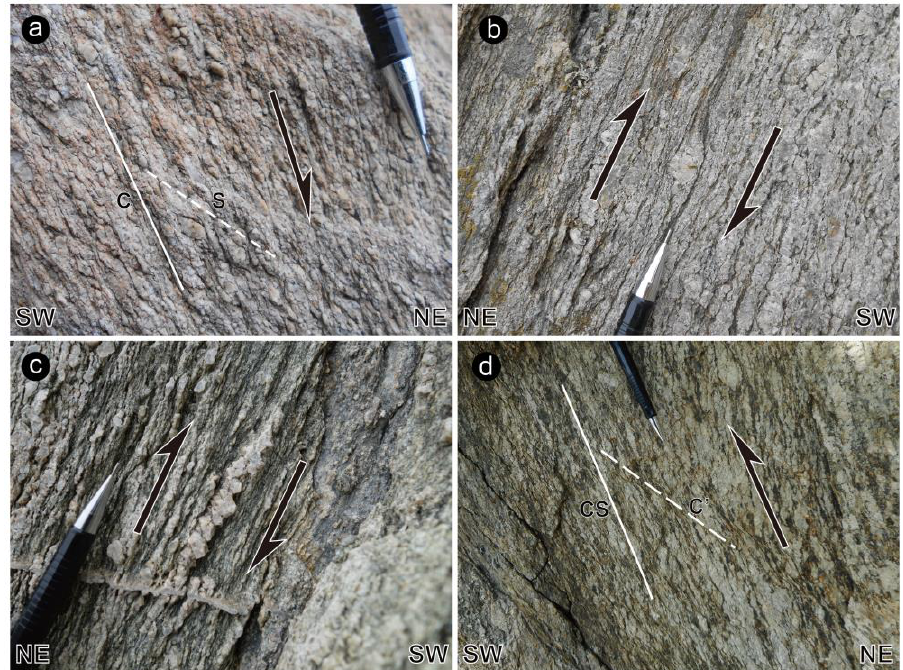
Figure 6. Outcrop-scale shear sense indicators in the Deokjeok Shear Zone (DSZ) ( a ), and the Soya Shear Zone (SSZ) ( b – d ). ( a ) S–C structure. ( b ) σ-type strain shadow. ( c ) Antithetic shear fracture (bookshelf structure). ( d ) Extensional crenulation cleavage (C’ shear band) inclined at 30°–40° to the earlier CS-foliation.